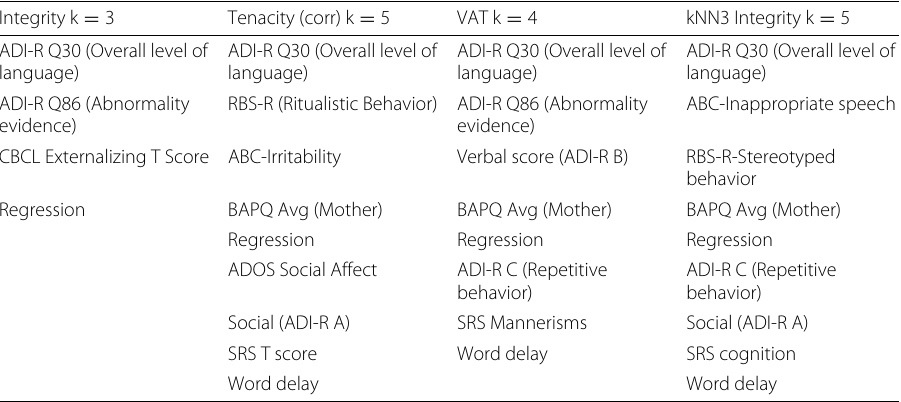
Table 8 Set of discriminant features by clustering result for complete clustering